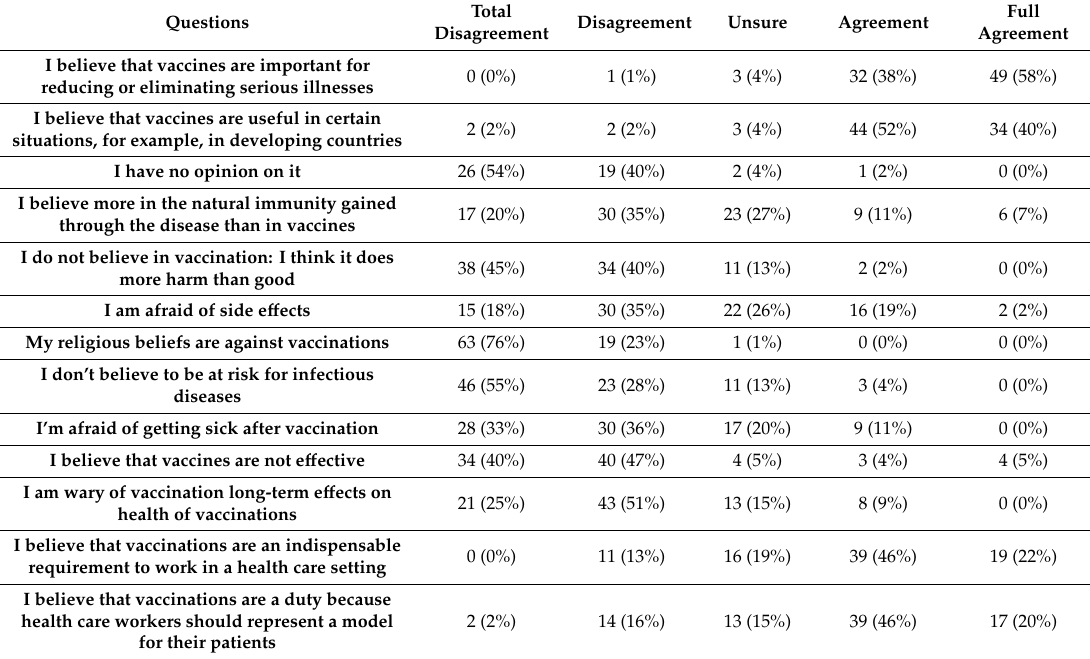
Table 2. Frequency distribution (values and row percentages) of the answers to Sections 1 and